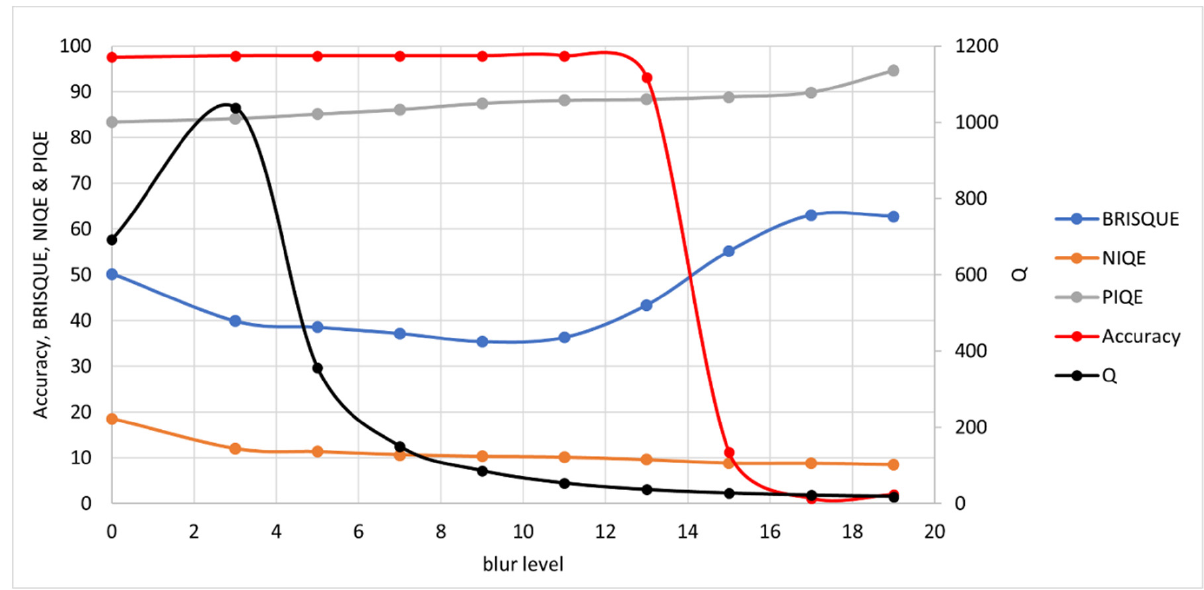
Figure 6. OCR Accuracy and Quality Metrics vs. Blur Level. Note: high BRISQUE, NIQE and PIQE values denote low quality while high Q values denote high quality. Again, a separate axis is used for Q here as the unnormalized Q value tends to be considerably higher than the other NR-IQAs, which tend to stay in the range 0 to 100.